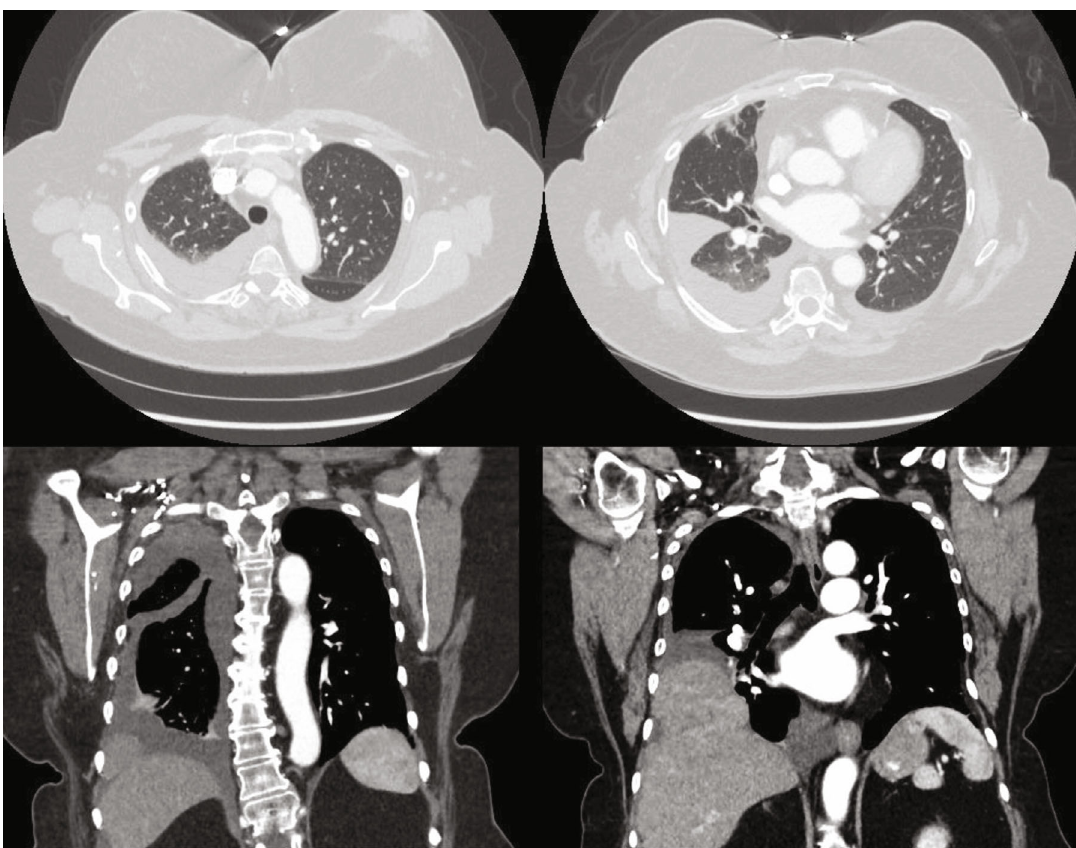
Figure 1: CT chest and abdomen showing right-sided pleural e ff usion and right lateral diaphragmatic